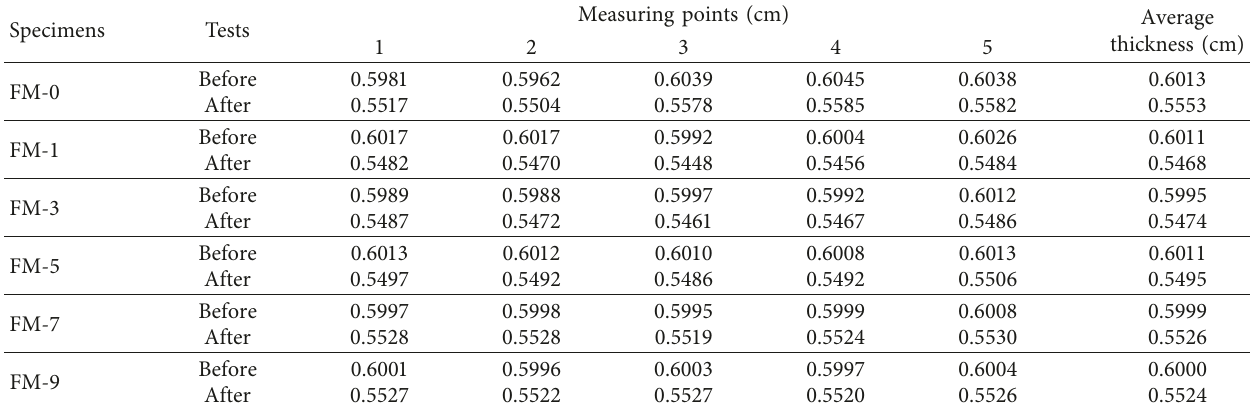
Figure 7: Friction response of the composites: (a) fade test runs and (b) recovery test runs. Table 3: The average thickness of each specimen before and after the test.